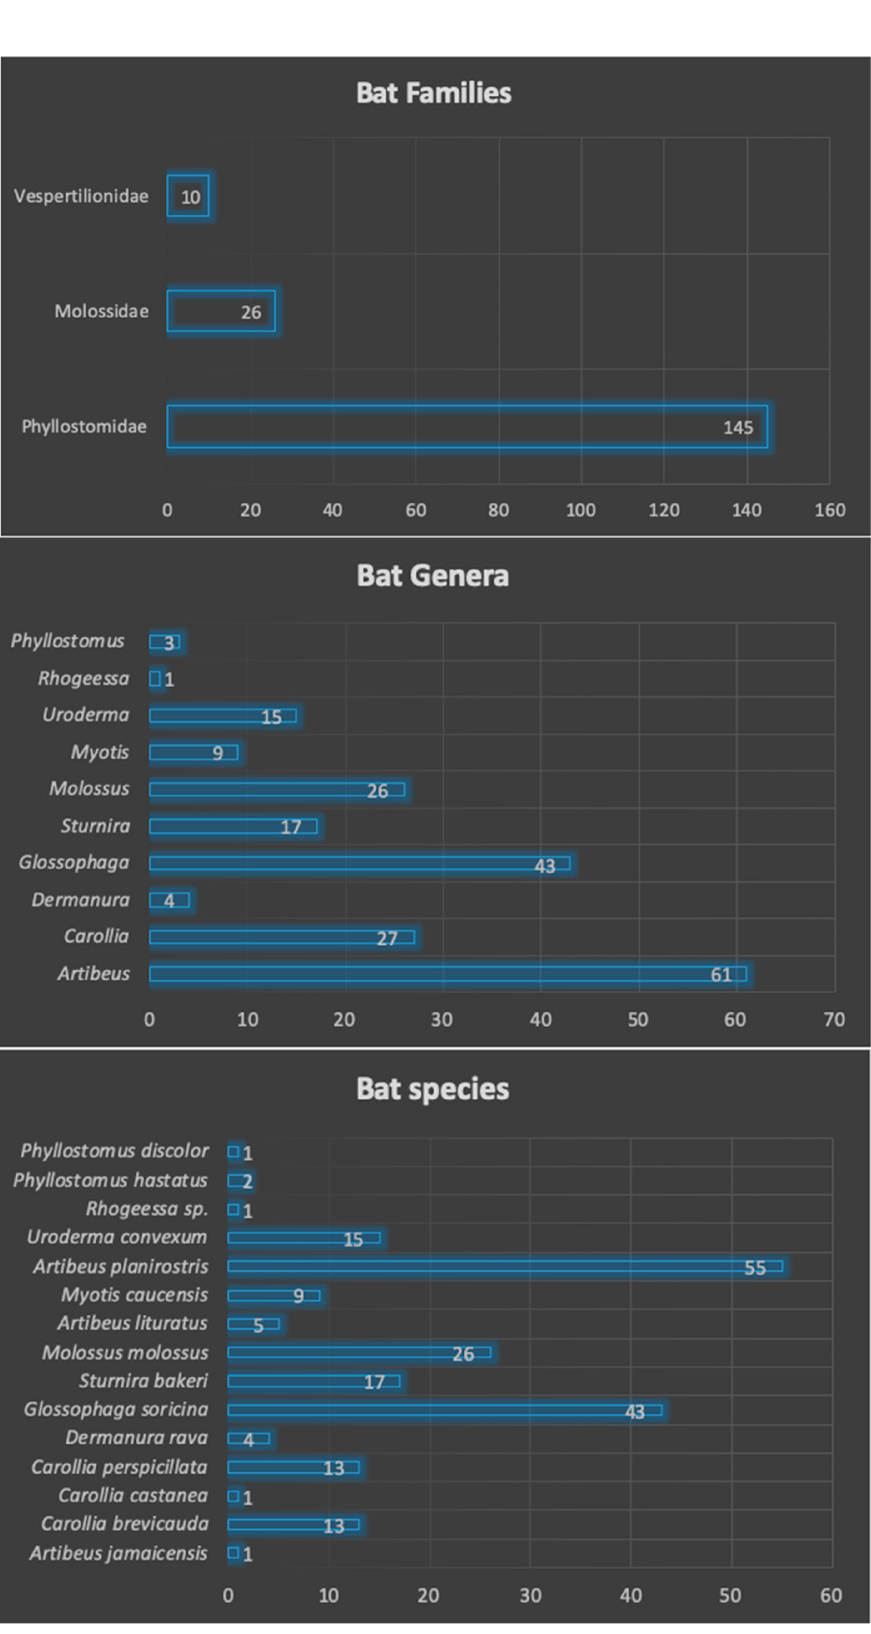
Figure 2. Diversity and abundance of bats captured in the five municipalities of the Urabá region. Figure 2 shows the 3 families, 10 genera, and 15 species of bats that were captured in the five sampling areas. The number of individuals for each taxonomic group classification are also indicated.